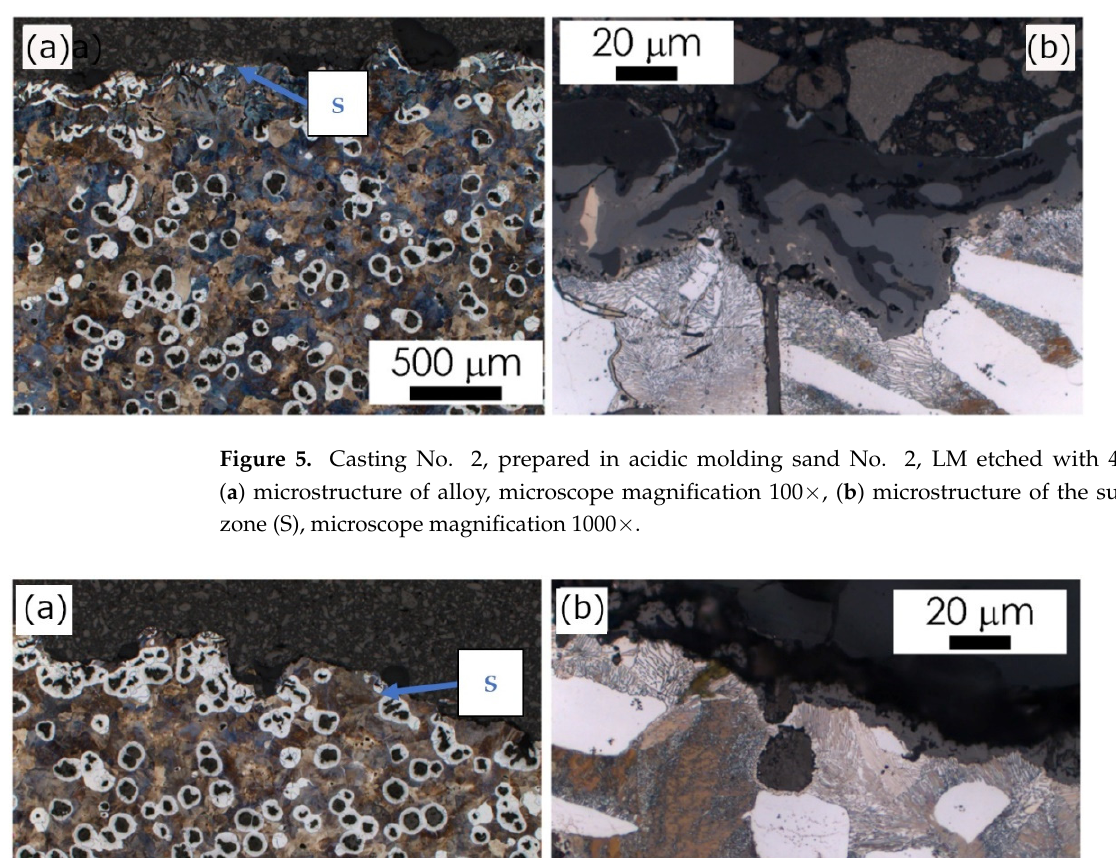
Figure 4. Casting No. 1, prepared in acidic molding sand No. 1, LM etched with 4% Nital; ( a ) microstructure of alloy, microscope magnification 100 ×, ( b ) microstructure of the superficial zone (S), microscope magnification 1000 ×.